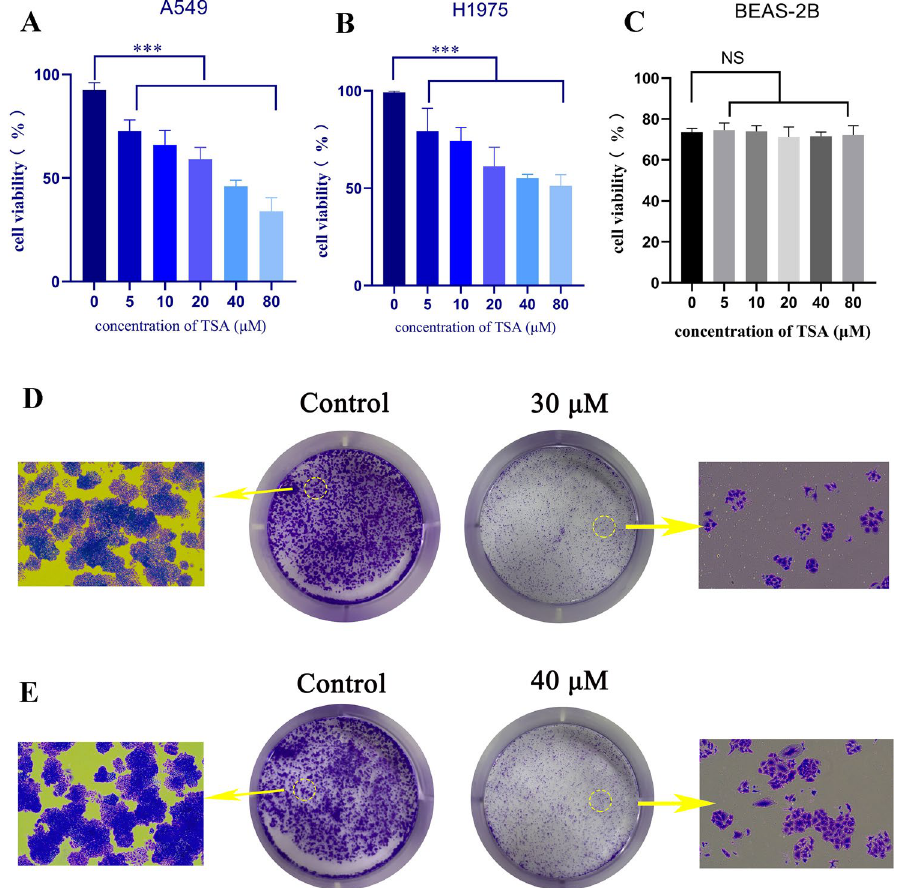
Figure 6. Effect of TSA on the viability of A549 ( A ), NCI-H1975 ( B ) and BEAS-2B ( C ) cells, after treatment with TSA for 24 h, the viability of these cells was measured by MTT assay, *** P < 0.001 vs. control. Plate